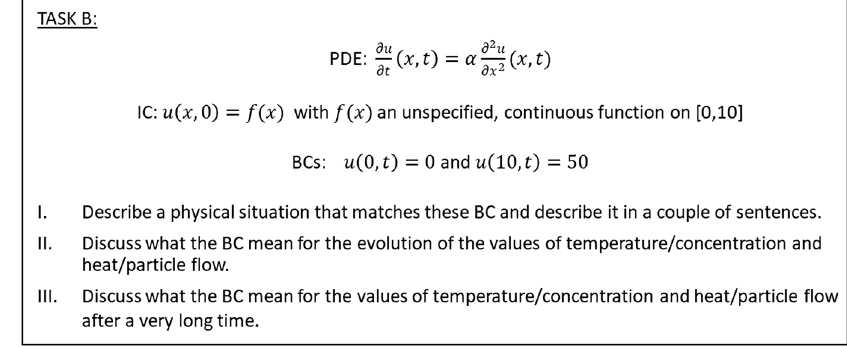
FIG. 7. Interview question: Task B.